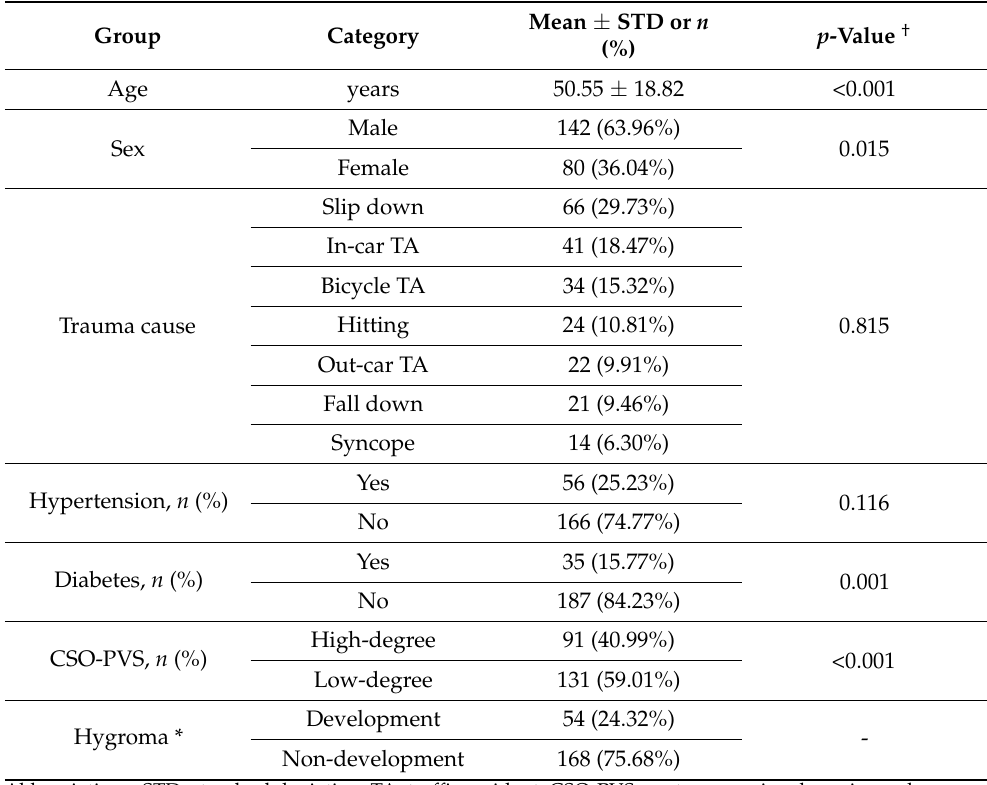
Table 1. Analysis of demographics for the development of de novo subdural fluid collection in patients with mild traumatic brain